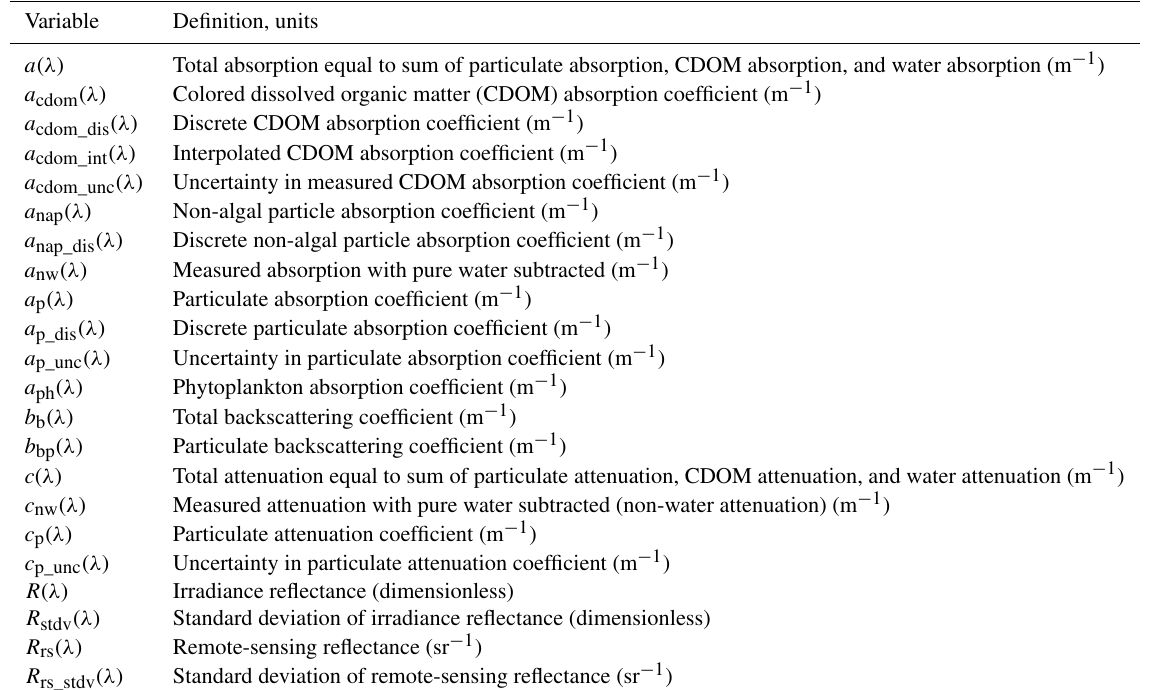
Table 1. List of variables included in the database. Variables are provided as defined by contributor. The symbol “ λ ” represents light wavelength in a vacuum in nanometers (nm). The term “discrete” is used to indicate a water sample removed from the aquatic